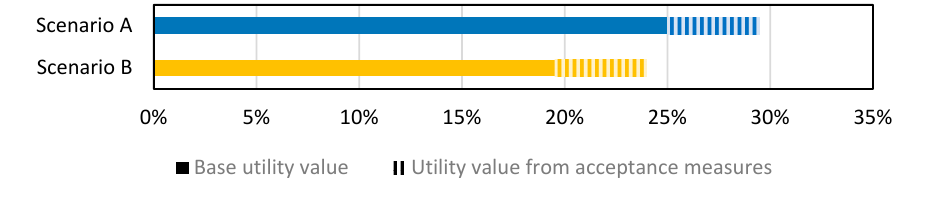
Figure 8. Overall utility values U A and U B .